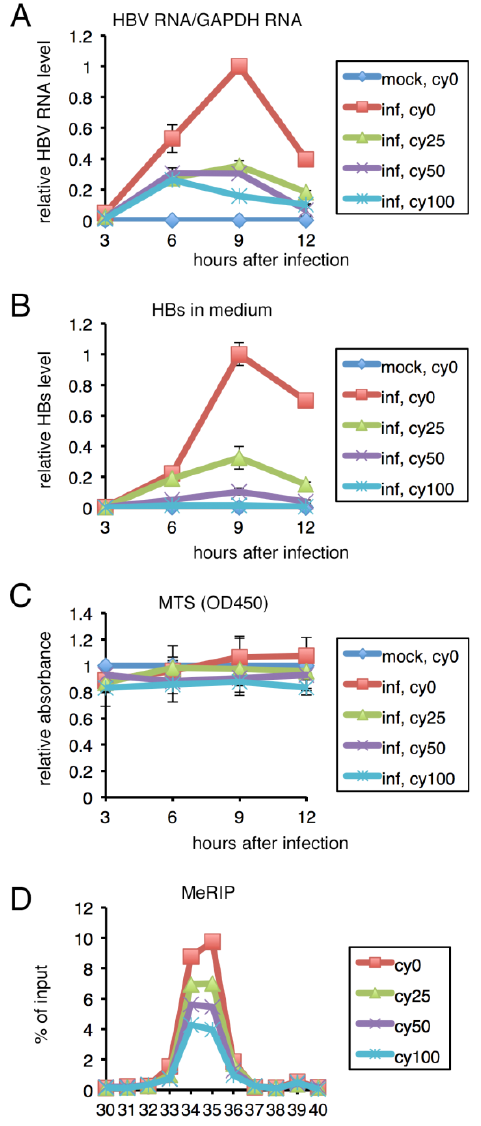
Figure 4. Effect of cycloleucine in PHHs. ( A – D ) PHHs were pretreated with the indicated concentra- tions of cycloleucine (mM) for 1 h and infected with HBV in the presence of 4% PEG and cycloleucine. RNA and culture medium were harvested for qRT-PCR ( A ) and HBs ELISA ( B ), respectively. MTS assay was conducted to examine cell viability ( C ). ( A – C ) Means ± standard deviation (SD) of three independent biological replicates are shown. ( D ) RNA was isolated from the cells and subjected to MeRIP analysis, which was followed by qRT-PCR. We next evaluated the effect of the m 6 A methylation inhibitor, cycloleucine, on HBV in PHHs. Levels of HBV RNA and HBs production were monitored by qRT-PCR and ELISA (Fig. 4). Cycloleucine decreased the HBV RNA level in cells (Fig. 4A) and HBs level in medium (Fig. 4B) in a dose-dependent manner, whereas 3-[4,5-dimethylthiazol-2-yl]-5-